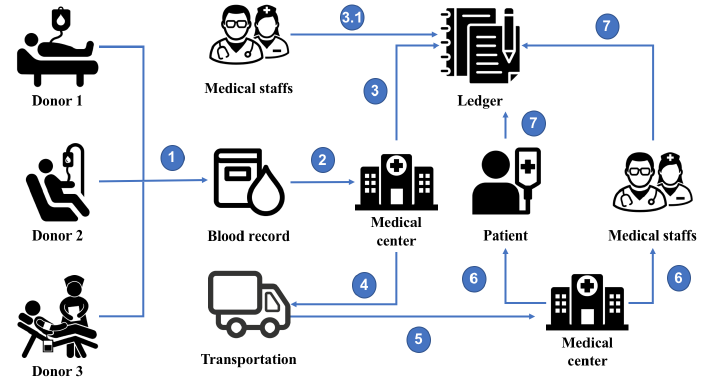
Figure 3. BloodChain overall